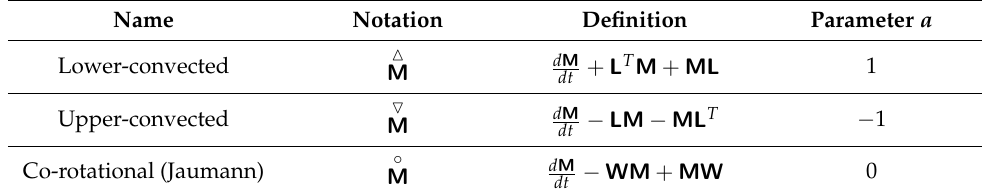
Table 1. Commonly used convected